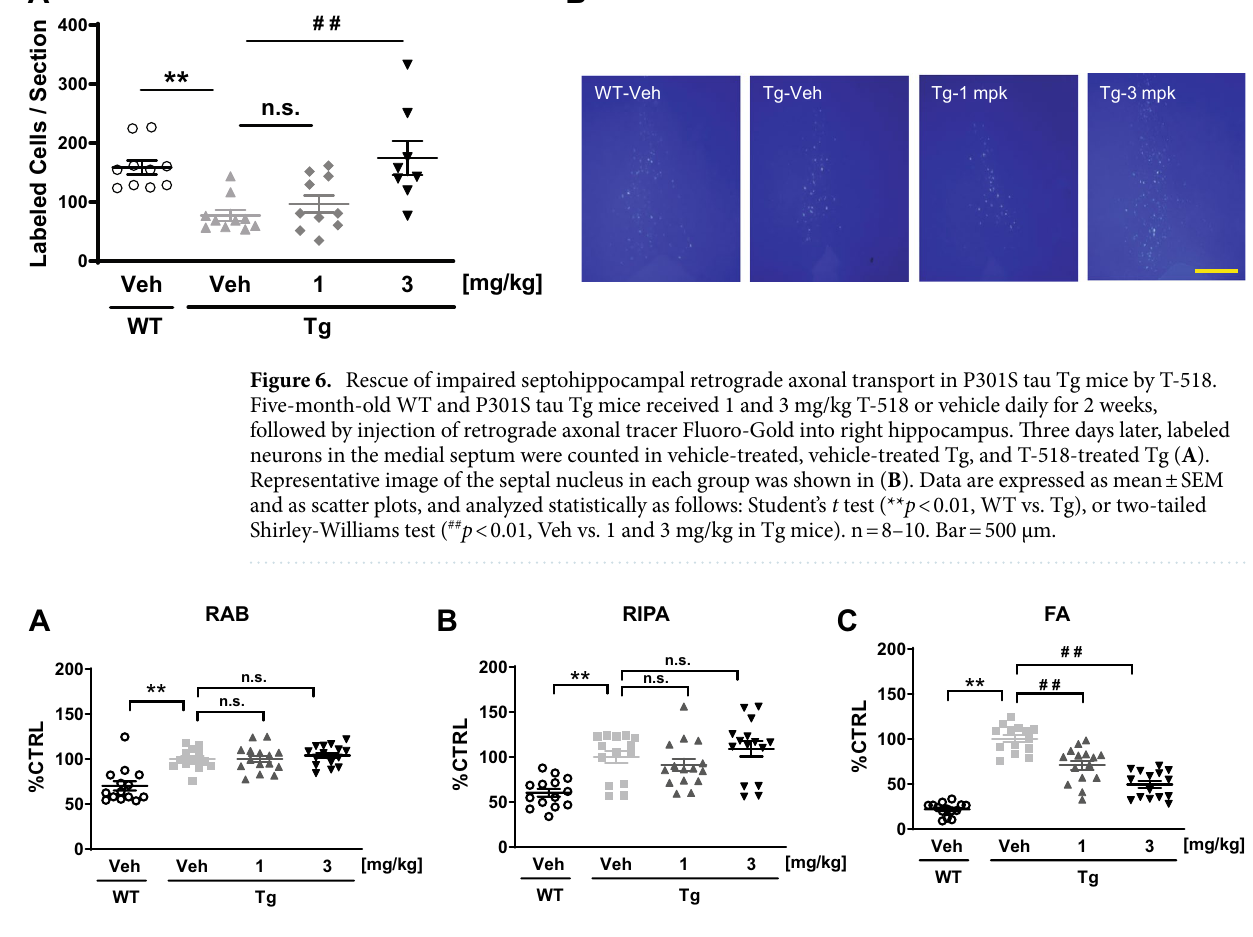
Figure 7. Mitigation of tau accumulation in P301S tau Tg mice by T-518. Six-month-old P301S tau Tg mice were treated with vehicle or T-518 (1 and 3 mg/kg) daily for 3 months. The hippocampus was isolated and RAB ‒ RIPA ‒ FA extraction was performed to assess the amount of insoluble tau by Western blotting and quantitatively analyzed. The original data of Western blotting is presented in Figure S4. Data are expressed as scatter plots and as mean ± SEM, and analyzed statistically as follows: Aspin-Welch t test (** p < 0.01, WT-Veh vs. Tg-Veh) or two-tailed Williams test ( ## p < 0.01, Tg-Veh vs. Tg-1 or 3 mg/kg). n = 14 or 15. n.s. not